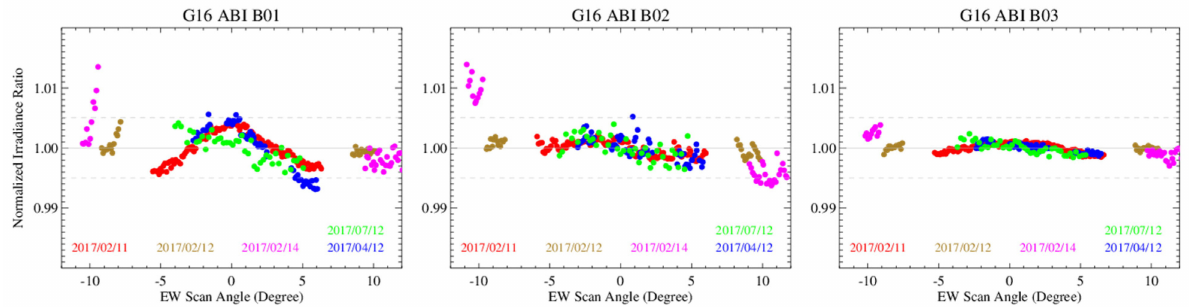
Figure 14. The normalized lunar irradiance ratio versus the scan angle for G16 B01–B03, after the spacelook correction with Equation (8).